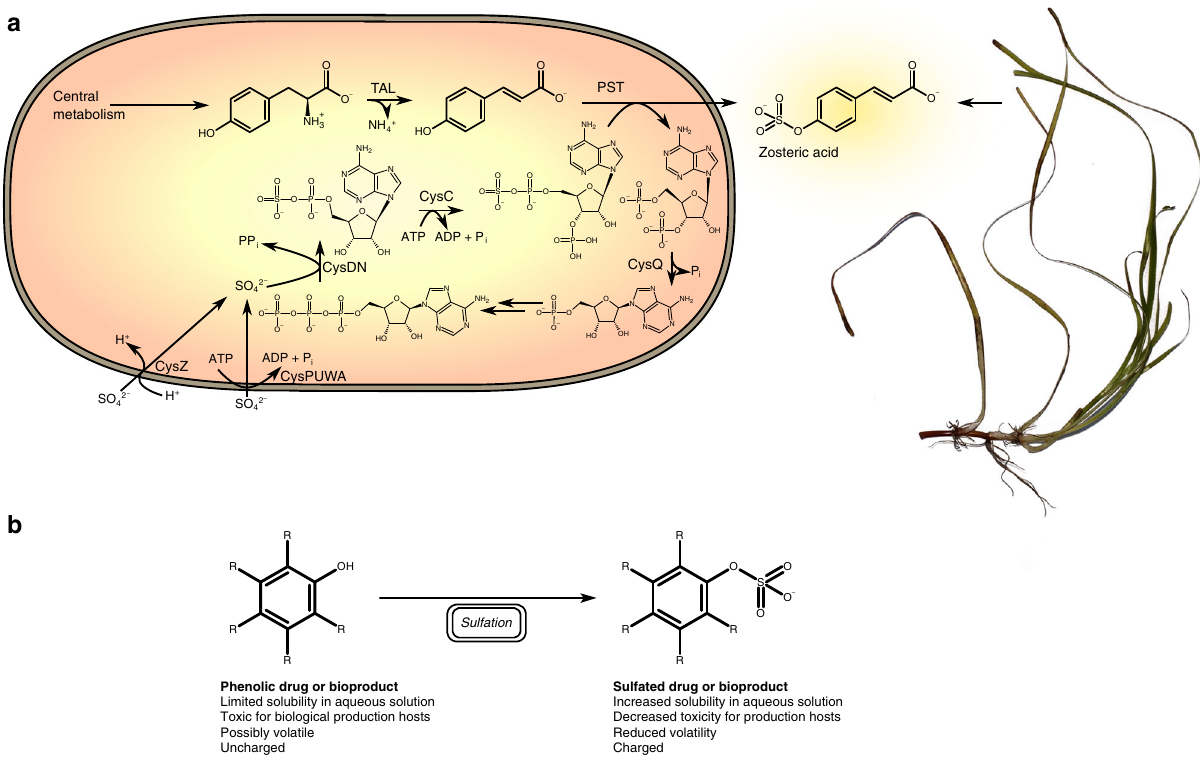
Fig. 1 The zosteric acid microbial cell factory. a The optimized cell factory for producing sulfated biochemicals is exempli fi ed by the production of zosteric acid, a plant biochemical from eelgrass (right side). The cell factory expresses a tyrosine ammonia-lyase (TAL) for deamination of tyrosine, a phenol sulftransferase (PST) for O -sulfonation of p -coumaric acid, and overexpresses uptake mechanisms for sulfate (here either CysZ or CysPUWA) as well as enzymes for activation of sulfate into 3 ′ -phosphoadenosine 5 ′ -phosphosulfate by CysDN and CysQ, and hydrolysis of 3 ′ -phosphoadenosine 5 ′ -phosphate (CysQ). b Sulfation as a general process for modifying a drug or a biologically produced compound for enhanced